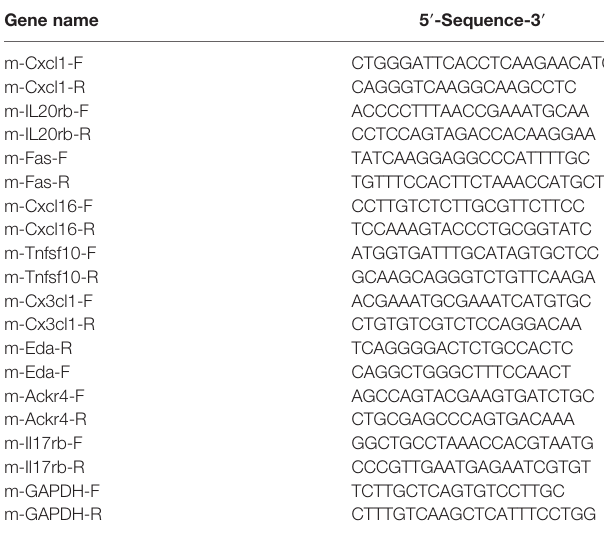
TABLE 1 | Sequence of primers used for real-time quantitative